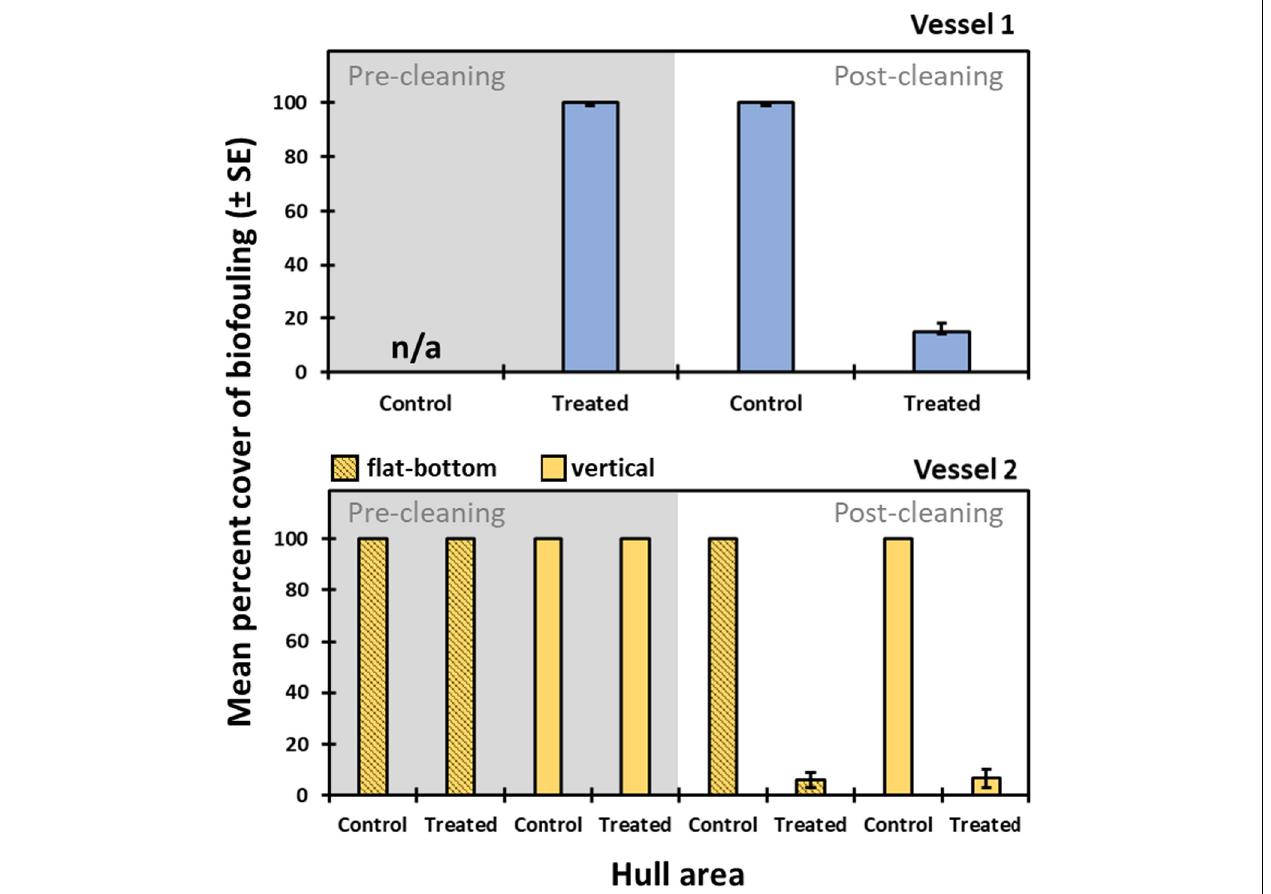
FIGURE 2 | Percent cover of biofouling (mean ± SE) for different hull areas (treated and control) prior to cleaning and after cleaning. Data are based on point-count surveys for Vessel 1 (top) and Vessel 2